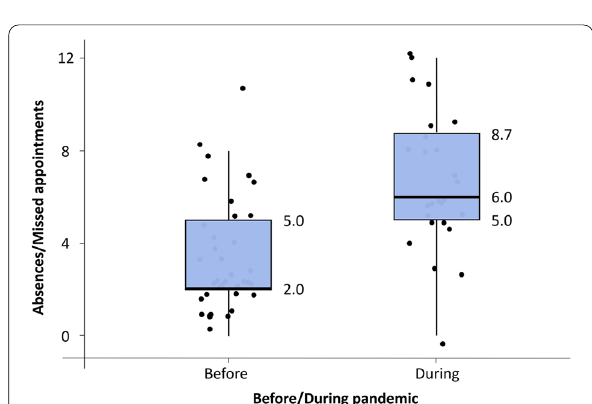
Fig. 4 Box plot (median/DIQ) for absences/missed appointments of patients in the pre-pandemic and pandemic